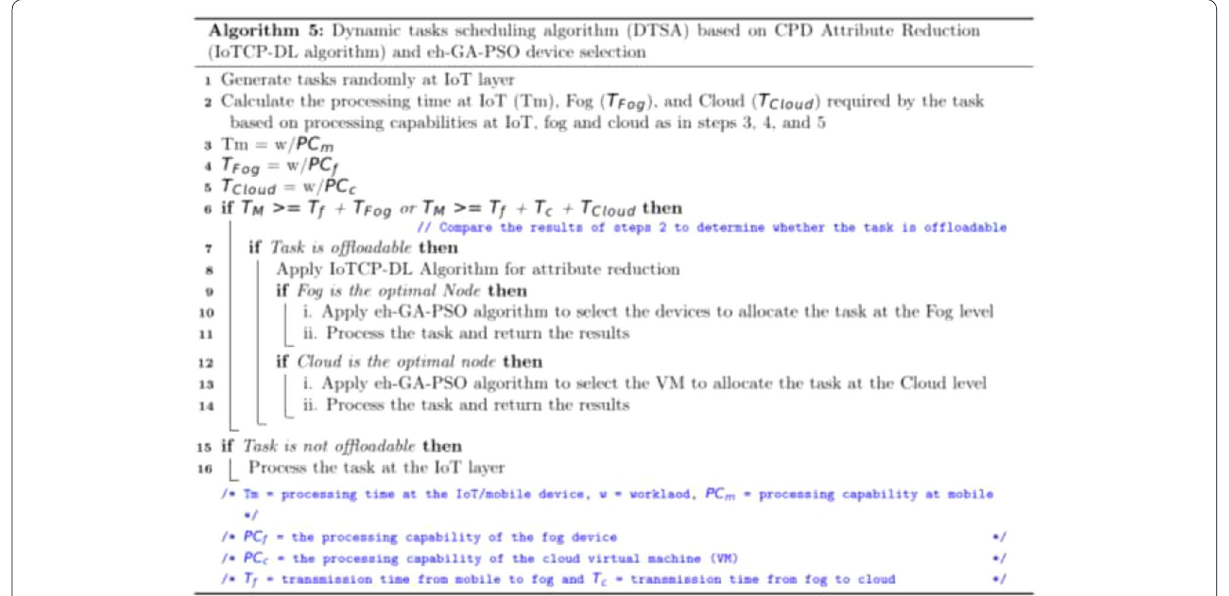
Fig. 7 Dynamic tasks scheduling algorithm based on attribute reduction and eh-GA-PSO for optimal device selection